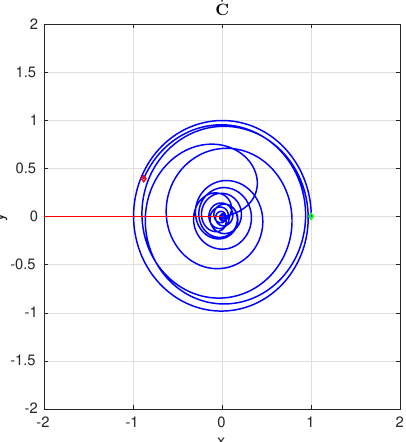
Figure 4. Path γ ( ω ) traced by (8) on the complex punctured plane ˙ C for the slab with d ef f = 300 nm. Green diamond marker: path starting point, ω = 0 Hz. Red diamond marker: path end point, ω = 1.5